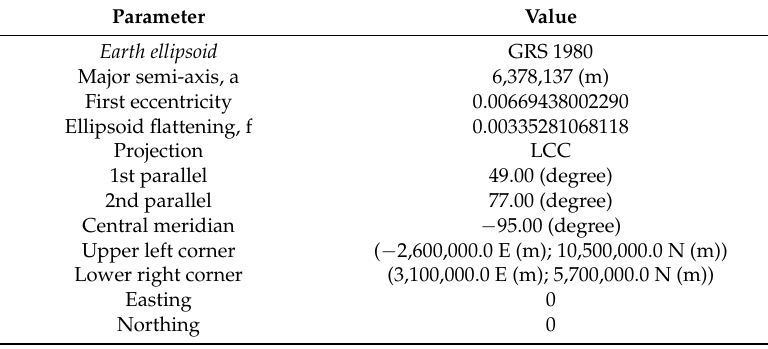
Table 1. The parameters of the Lambert Conformal Conic (LCC) projection and earth ellipsoid model used for output imagery over Canada.